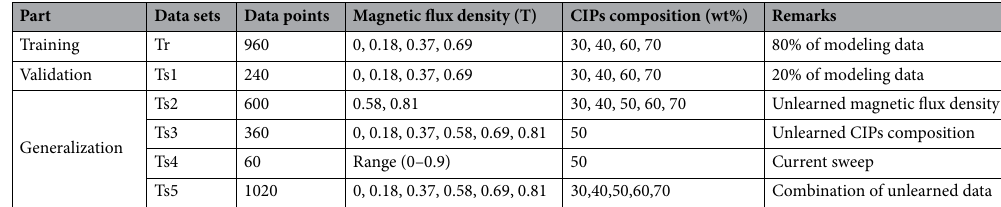
Table 5. Data division for isotropic and anisotropic MR elastomer.